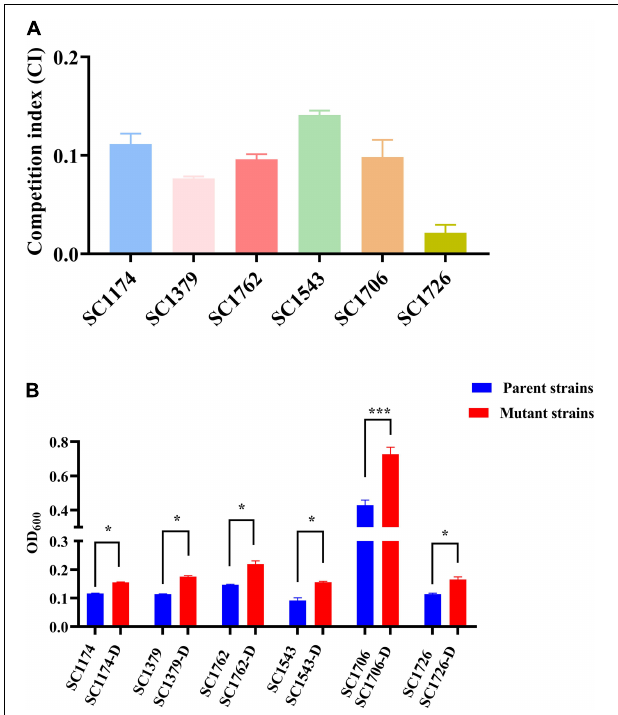
FIGURE 9 | In vitro competition index and biofilm formation ability. (A) The in vitro CI in parental isolates and mutants. (B) Levels of biofilm formation in parental isolates and mutants. -D, evolved DAP-R mutants. The error bars show standard deviation from three independent experiments, and the absorbance value at OD 600 was used to compare the biofilm formation ability of the DAP-S parental strains and respective evolved DAP-R strains with paired Student’s t -test (* P < 0.05 and *** P <